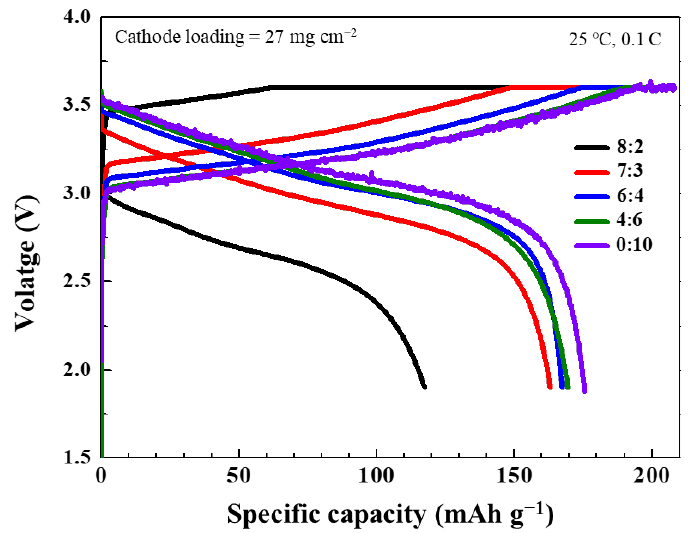
Figure 5. Charge–discharge profiles of the first cycle at 0.1 C of ASSCs with composite electrolytes with different LLZO:LPSC ratios. Table 2. Specific capacities of ASSCs with composite electrolytes with different LLZO:LPSC ratios. LLZO:LPSC (wt.%)